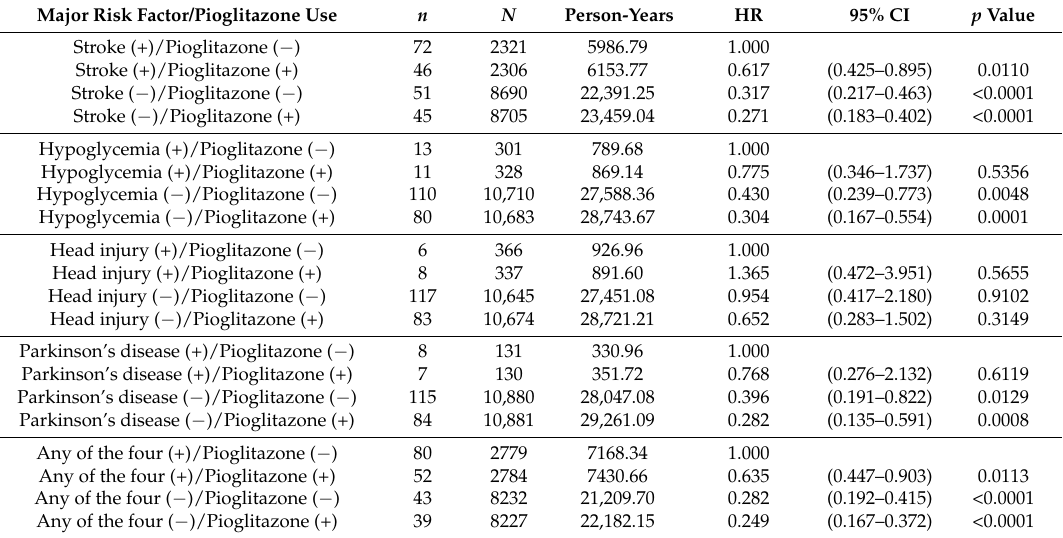
Table 4. Joint effects between pioglitazone and major risk factors of